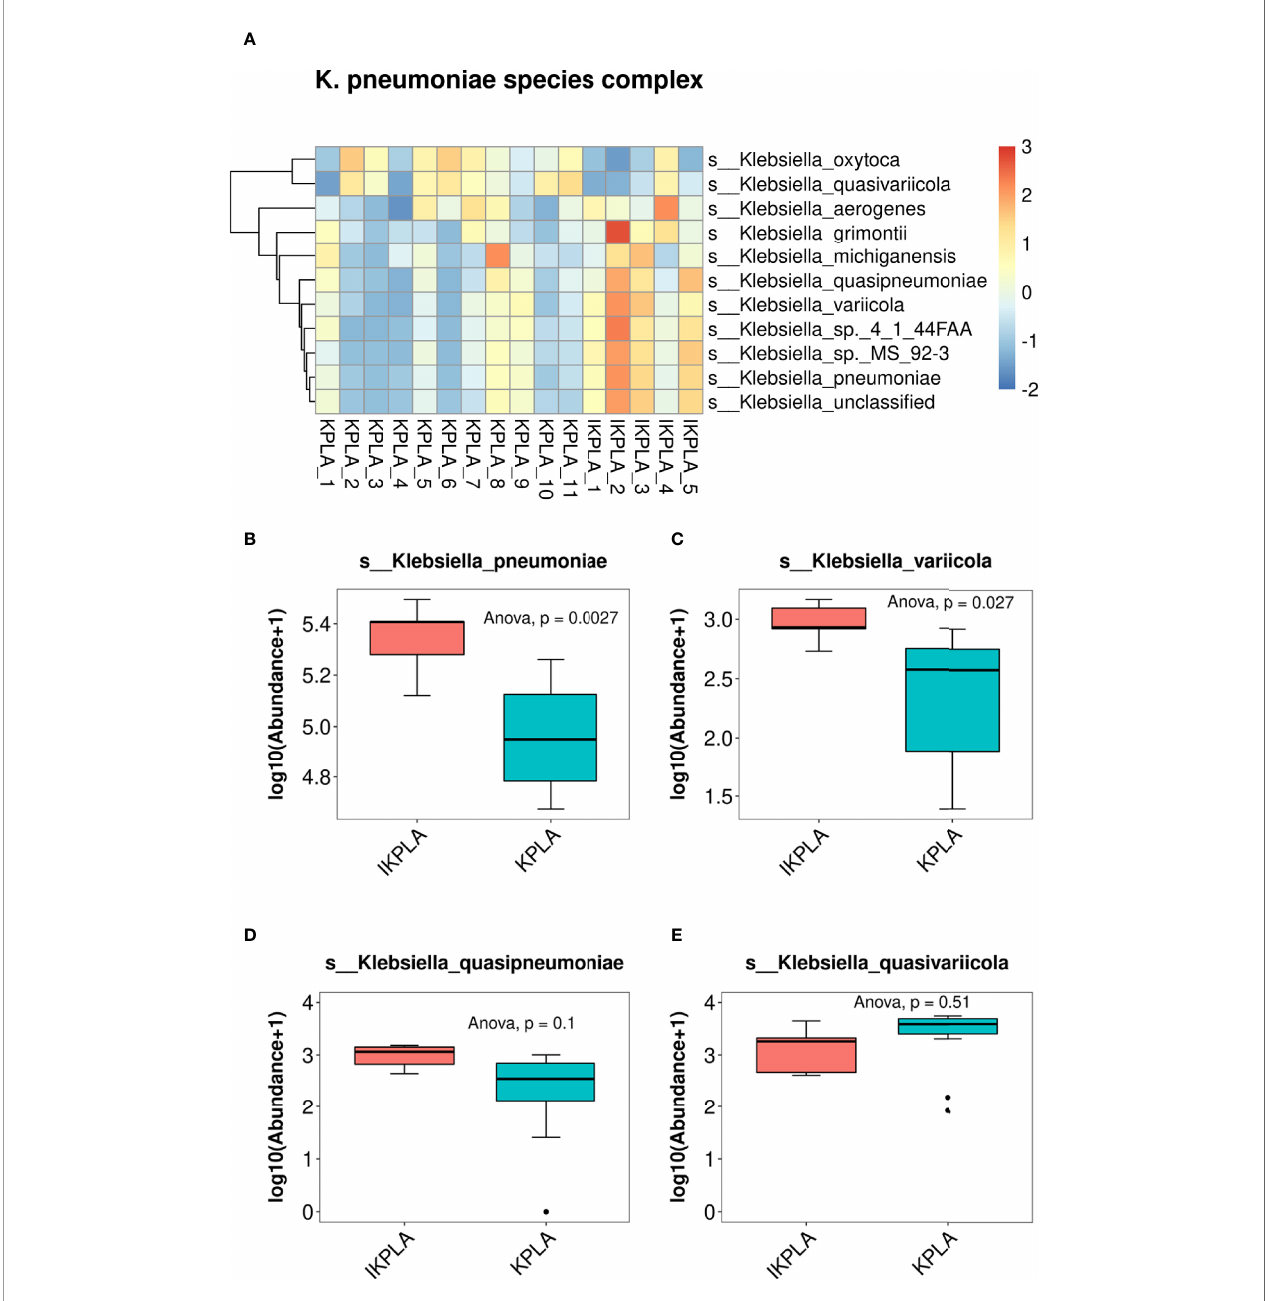
FIGURE 4 | Population structure of K. pneumoniae . The clustering correlation heatmap showed that there were differences in the abundance of many species of Klebsiella between KPLA and IKPLA (A) . Furthermore, comparative analysis was performed for four members of the Klebsiella pneumoniae species complex (KpSC). The results showed that the abundances of K. pneumonia (B) and K. variicola (C) were signi fi cantly different between the two groups, but there was no difference for K. quasipneumoniae (D) , and K. quasivariicola (E)